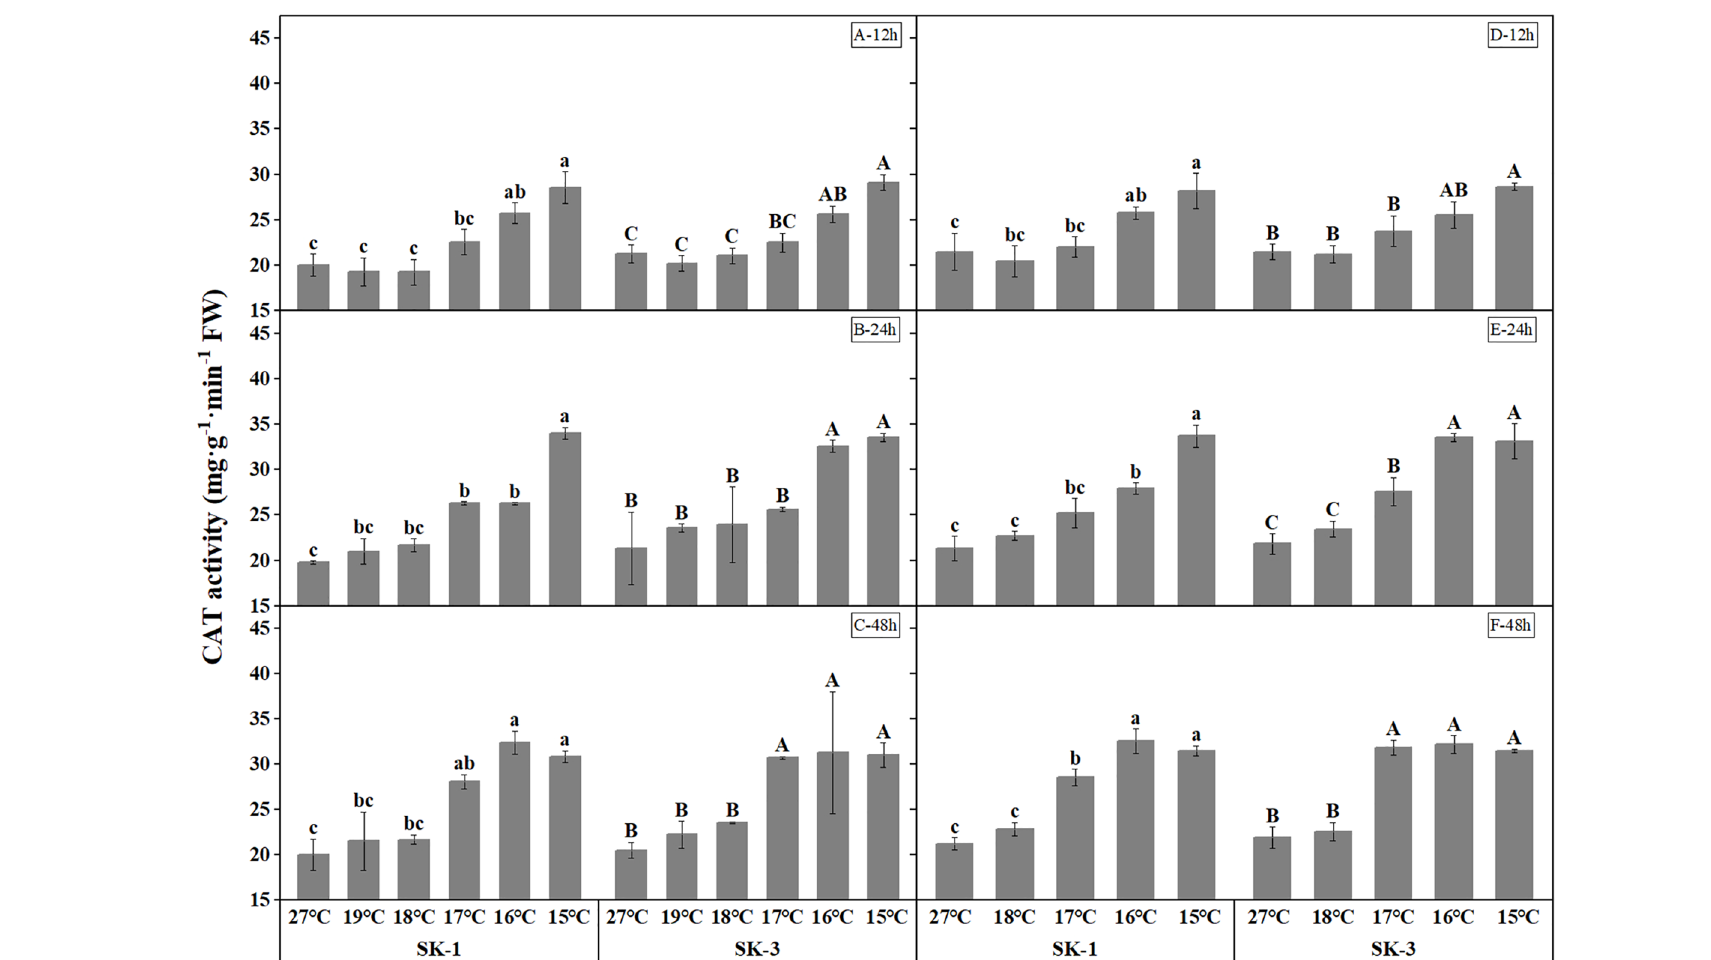
FIGURE 5 Effect of low temperature stress on CAT activity in cotton squares in 2020 ( A-C : 12h, 24h, 48h stress) and 2021 ( D-F : 12h, 24h, 48h stress). FW represents fresh weight. Different lowercase letters indicate the signi fi cant differences between the treatments of the variety SK1, and different capital letters indicate the signi fi cant differences between the treatments of the variety SK3